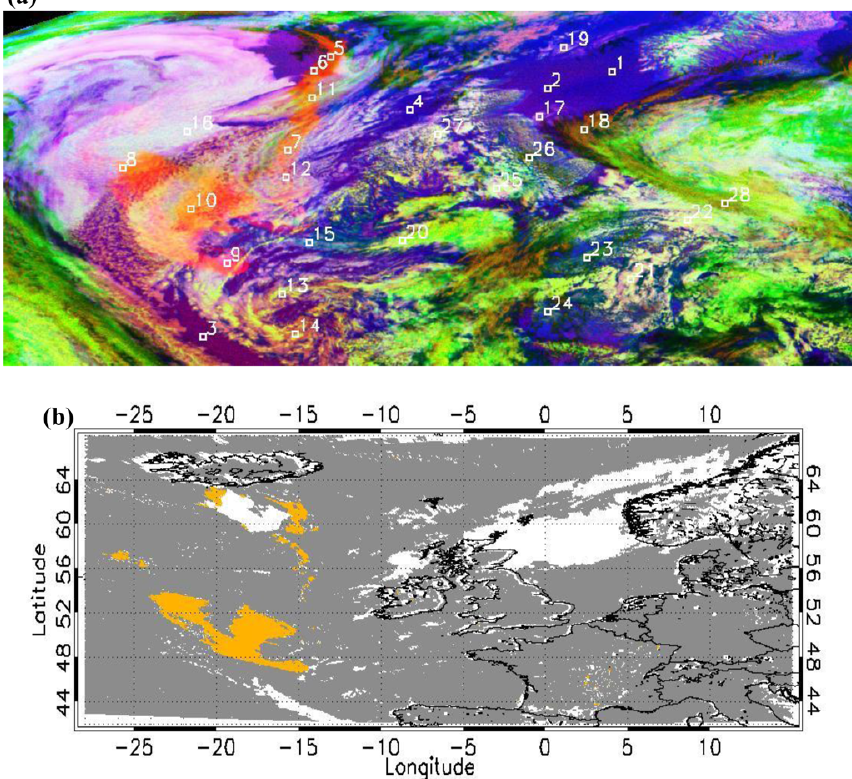
Fig. 8. (a) SEVIRI RGB image on 7 May 2010 at 11:00UTC over Europe and the Atlantic Ocean; the 28 boxes indicate the location of extracted samples for various scenes of clear-sky water (boxes 1–4), ash above cloud (boxes 5–12), and ash-free cloud (boxes 13–28). (b) SEVIRI algorithm results for this 7 May